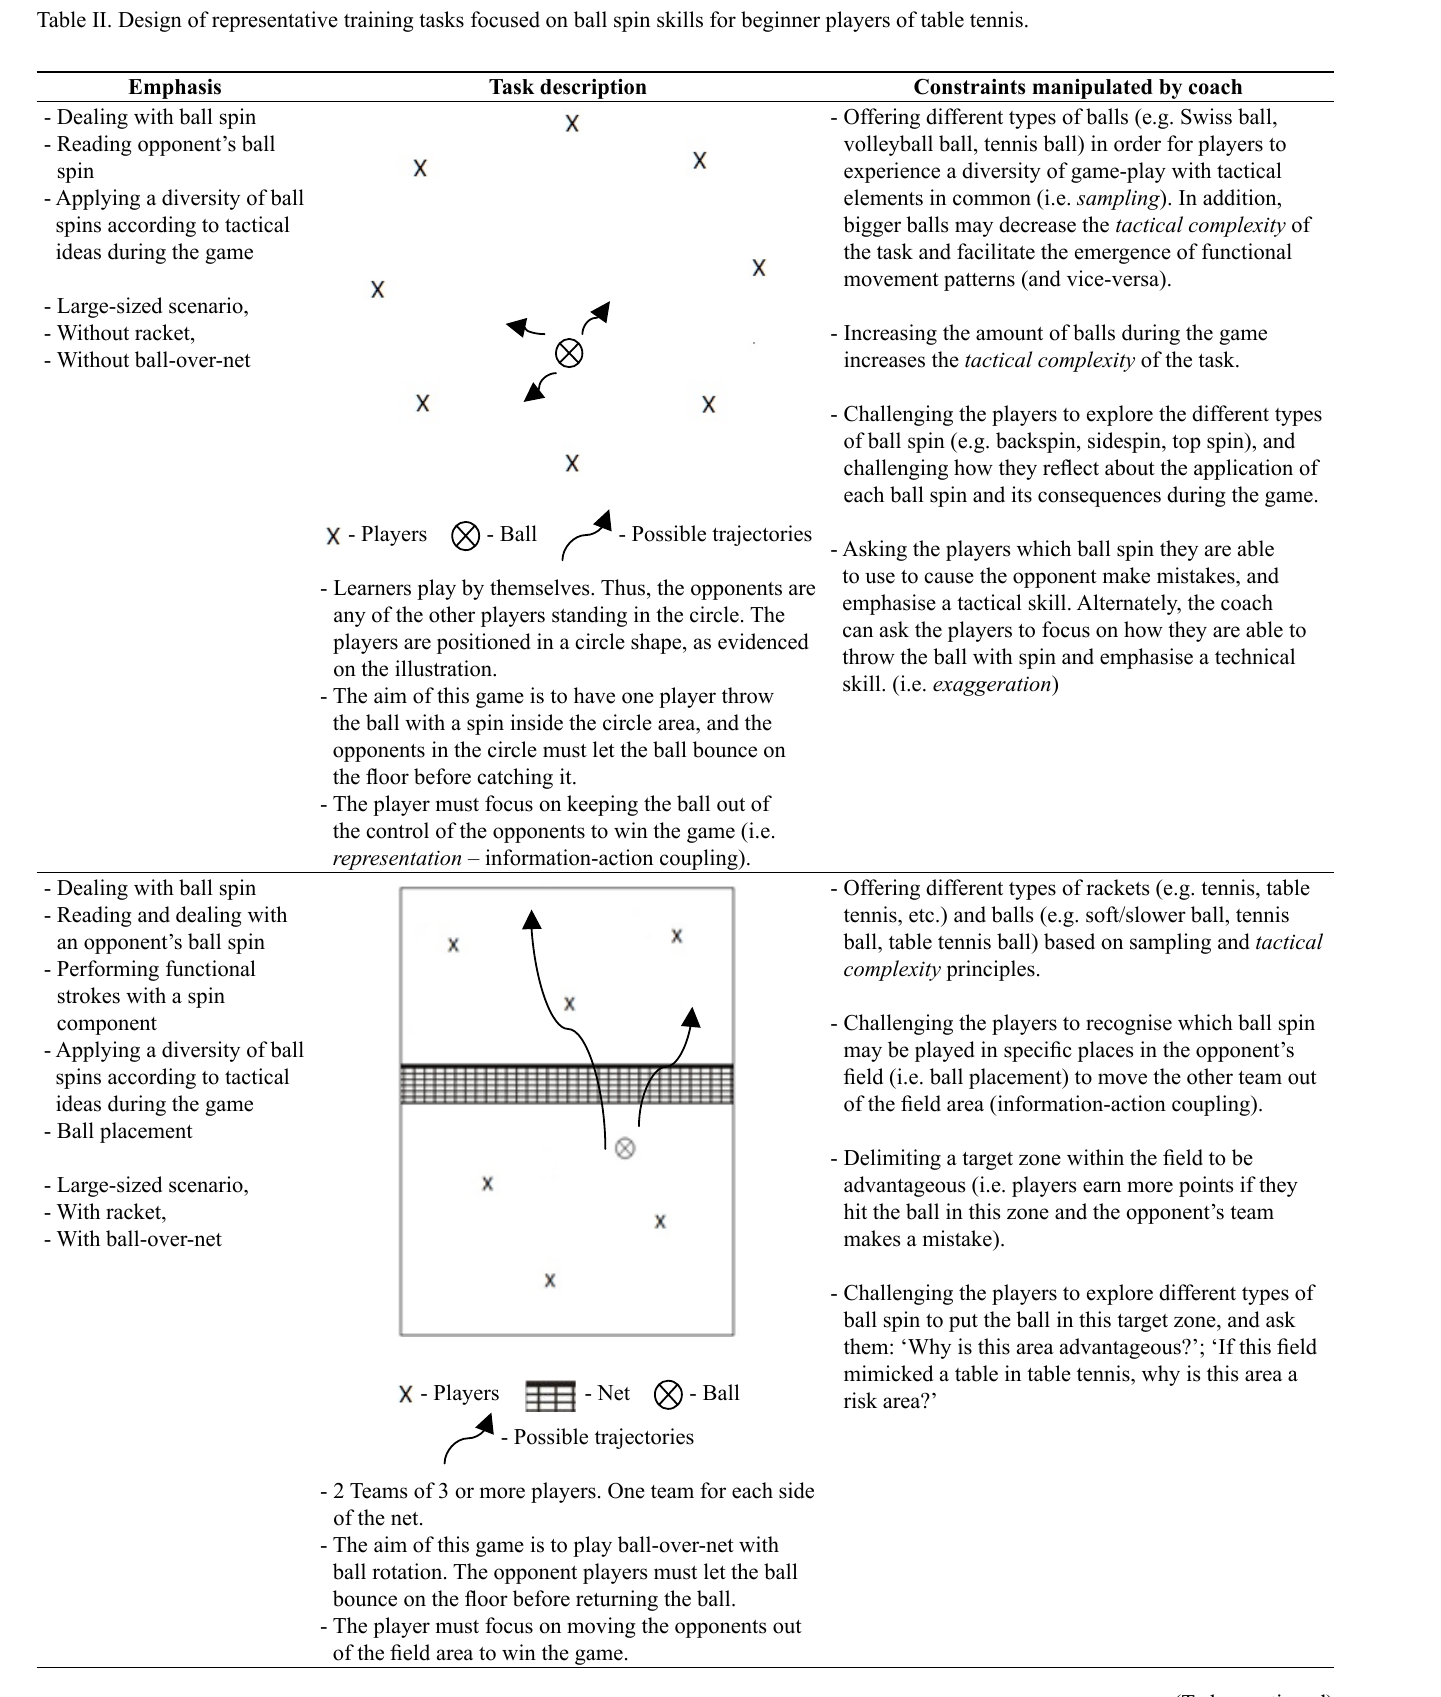
Table II. Design of representative training tasks focused on ball spin skills for beginner players of table tennis.